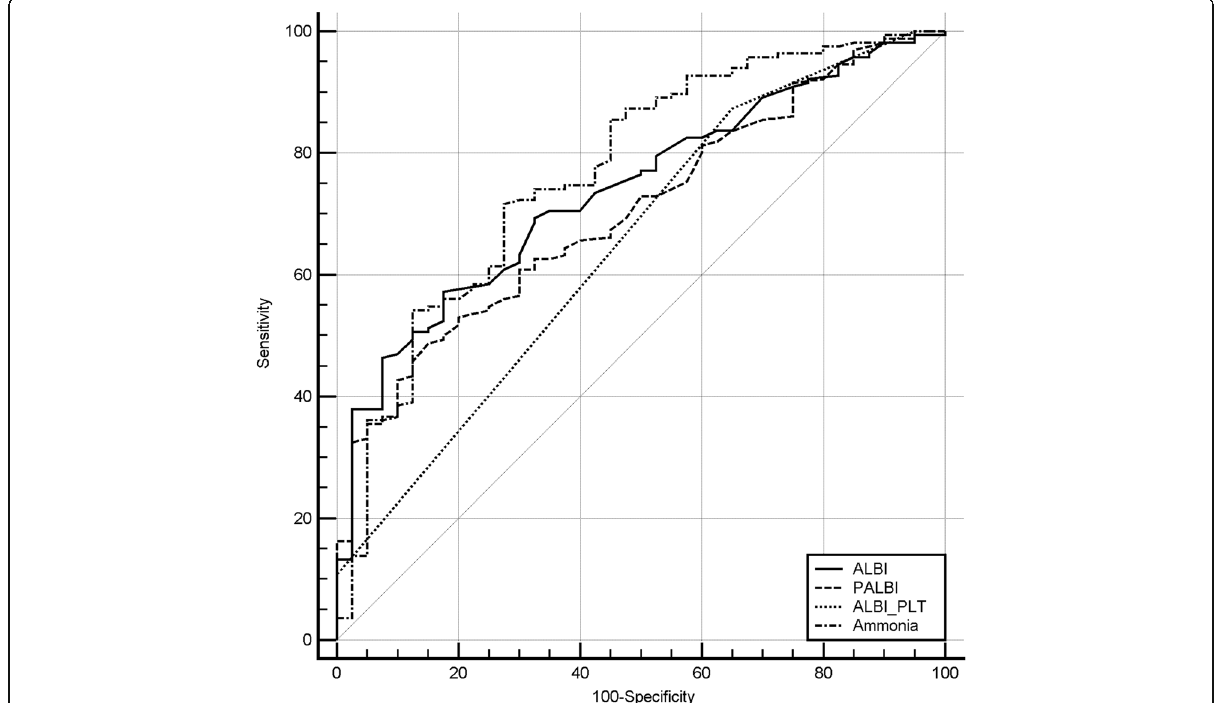
Fig. 3 The receiver operating characteristic (ROC) curve analysis of ALBI, PALBI, ALBI-PLT and ammonia in patients with and without